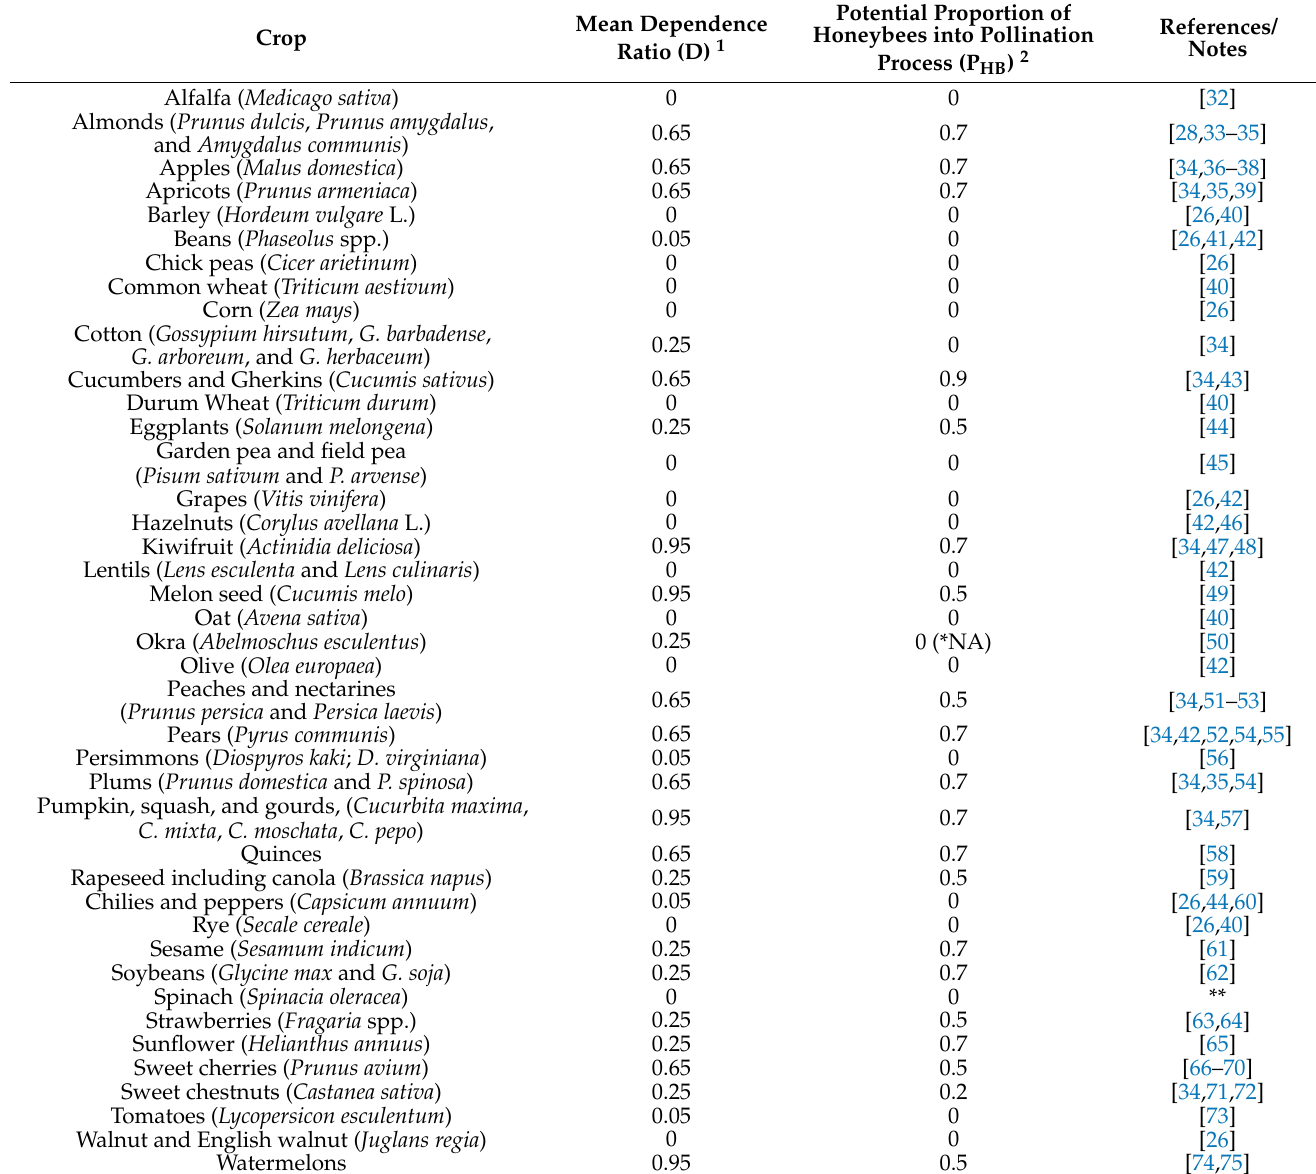
Table 2. Crop dependence on pollinators and participation of honeybees in pollination